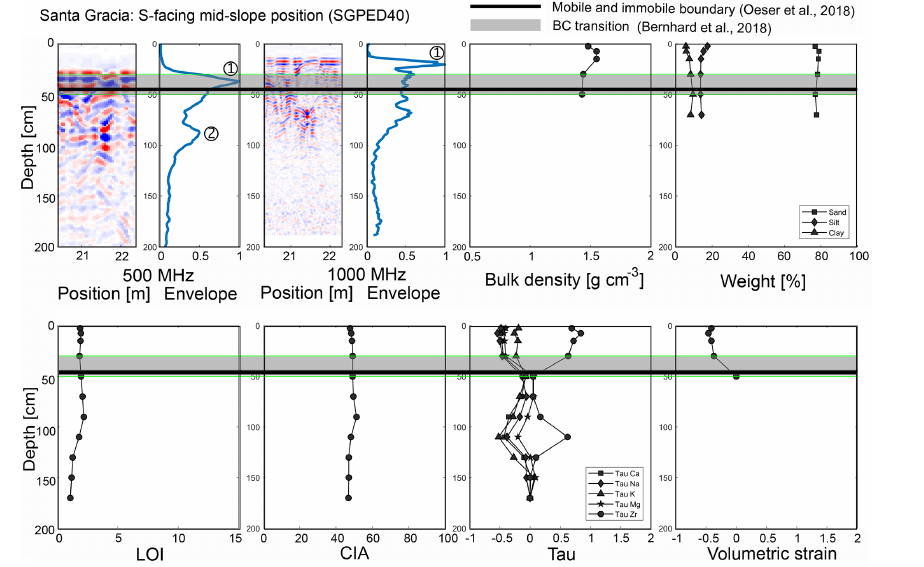
Figure 6. Compilation of physical and chemical investigations at the pedon location in the mid-slope position of the S-facing hillslope in Santa Gracia. Properties shown are listed in caption of Fig. 4. Table 3. Correlation coefficients R of 1000 and 500MHz GPR envelope with derivatives of physical and chemical properties for each study